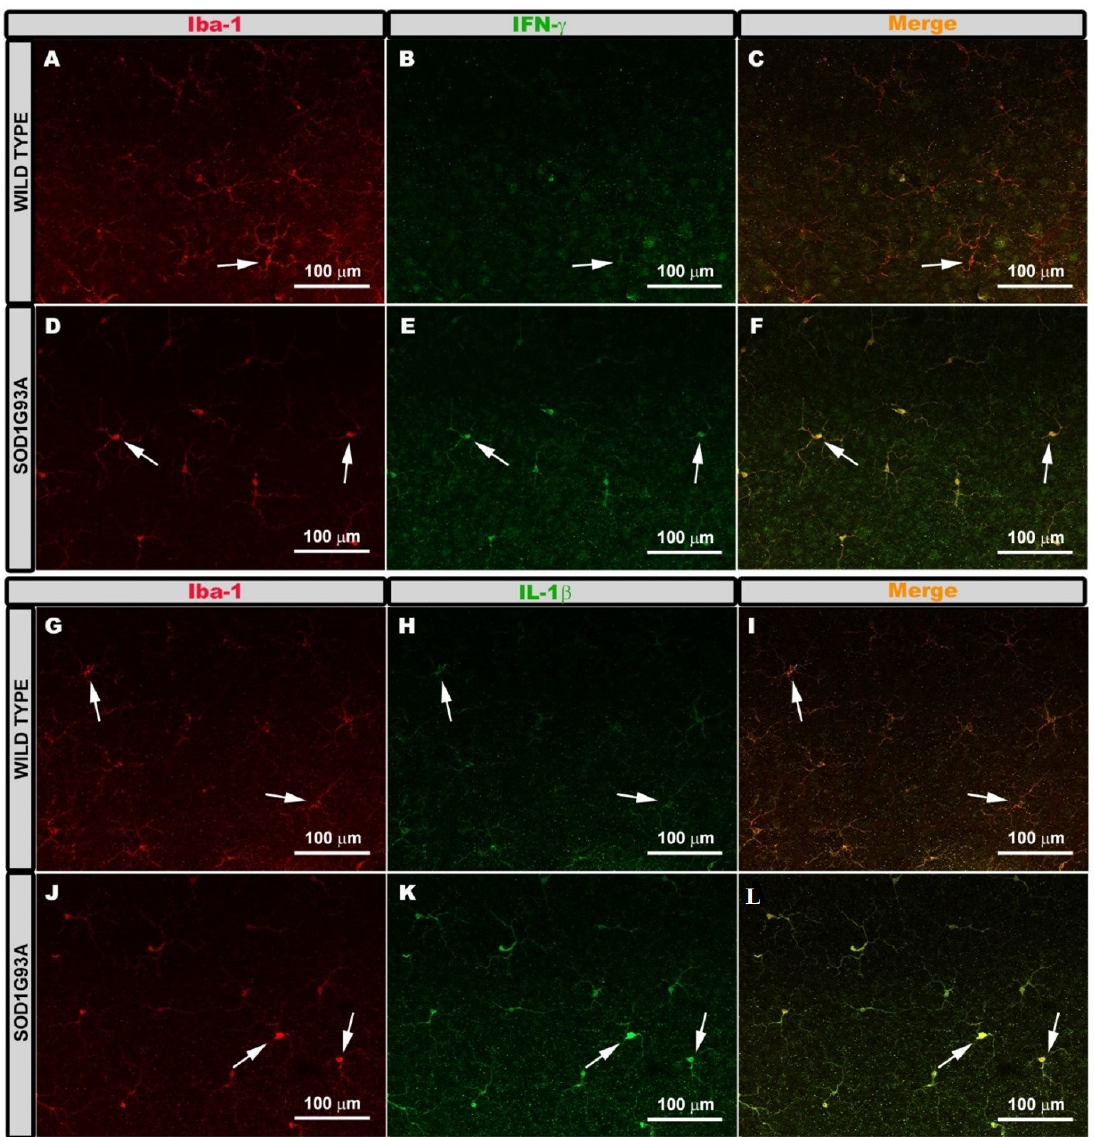
Figure 3. Pro-inflammatory M1 phenotype. Retinal whole-mounts are labeled with anti Iba-1 and anti IFN- γ ( A – F ) and with anti-iba-1 and anti-IL-1 β ( G – L ) showing the microglial plexus in the outer plexiform layer. Immunoreactivity for IFN- γ ( A – C ) and IL-1 β ( G – I ) in the Iba-1+ cells was very low in the wild type group (arrow). Iba-1+ cells of the SOD1G93A group showed very intense immunoreactivity for IFN- γ ( D – F ) and IL-1 β ( J – L ) (arrows). Number of retinas used in the experiment, WT: n = 3; and SOD1G93A: n = 3.